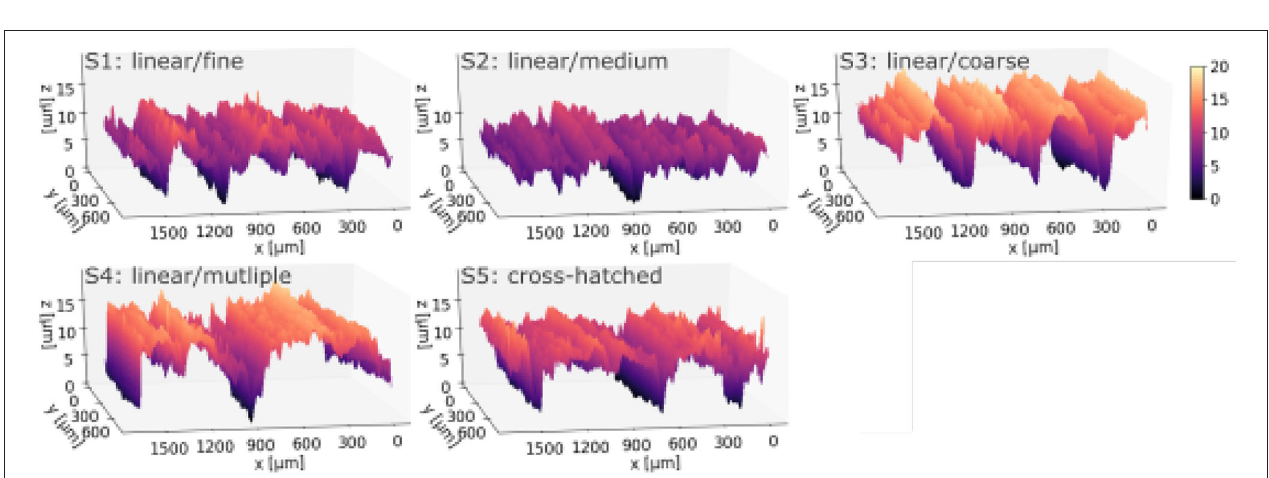
FIGURE 3 | Fractional contact area of the ski topographies S1–S5 in contact with an ice surface. Comparison of an elastic-plastic contact mechanics calculation (black curve) with a calculation considering plastic deformation, only (gray curve). The fractional contact area was calculated between the ski base and a plane surface having a hardness of 20 MPa and with an applied pressure of 20 kPa . The calculation considered the whole ski sole surface topographies having a nominal area of 1,660 × 800 µ m .